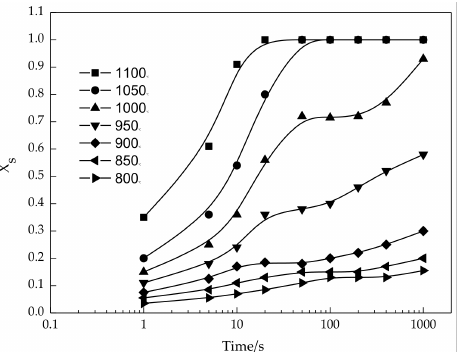
Figure 3. Relationship between static recrystallization fraction and interruption